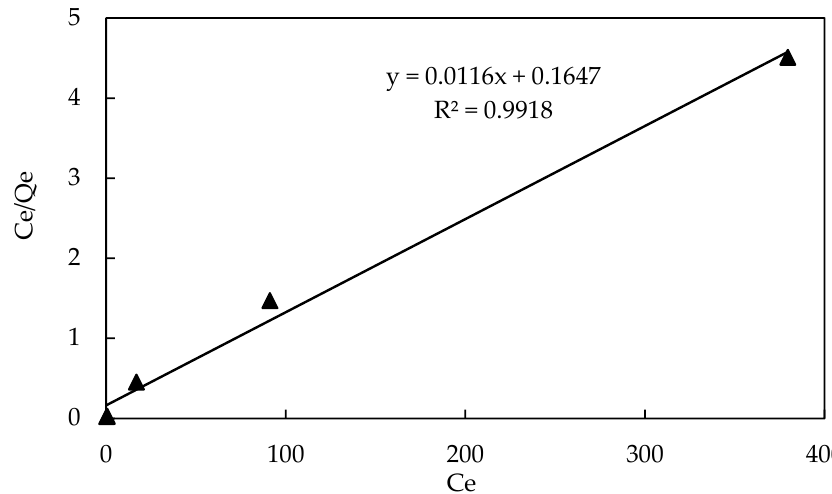
Figure 5. Langmuir adsorption isotherm for xanthate on activated carbon with various initial xanthate concentrations C 0 (50, 100, 200, 400 and 800 mg/L); volume of xanthate solution, 100 mL; amount of activated carbon, 0.5 g; contact time, 180 min. C e is the xanthate concentration at equilibrium.